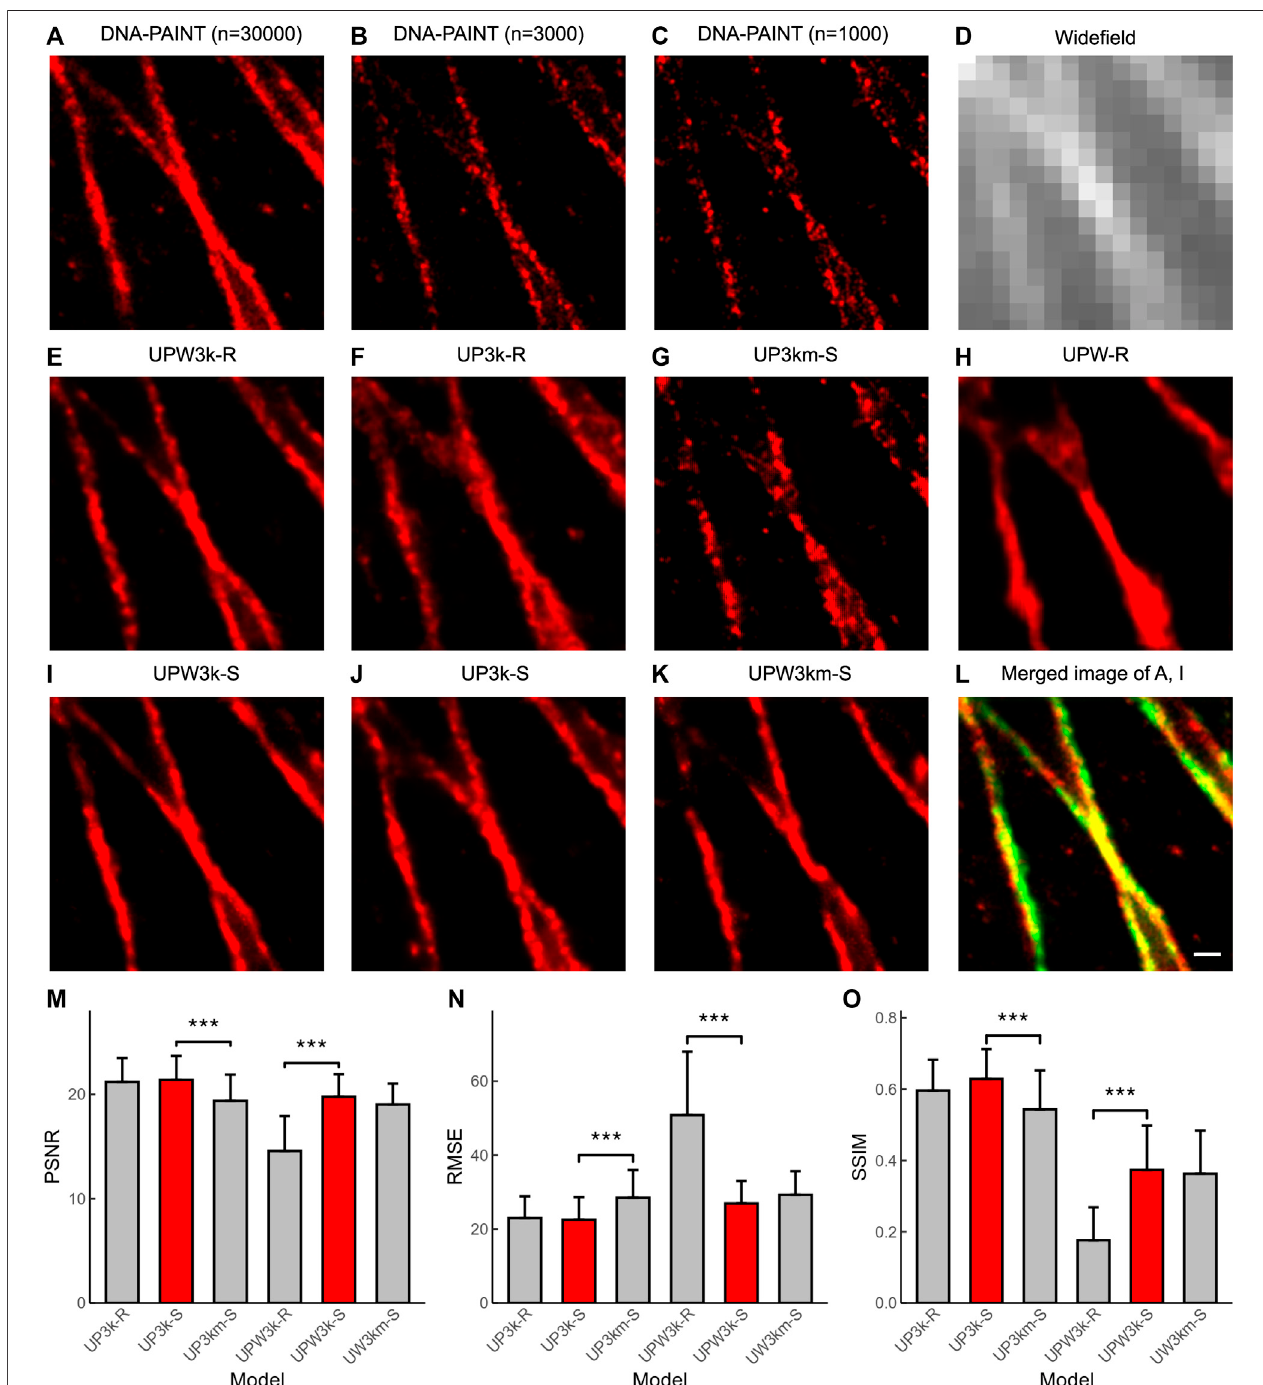
FIGURE 4 | U-PAINT reconstruction of microtubules. (A) DNA-PAINT reconstruction images with n = 30,000 raw data. (B) DNA-PAINT reconstruction image with n = 3,000 raw data. (C) DNA-PAINT reconstruction image with n = 1,000 raw data. (D) Wide fi eld image. (E) Real data-based U-PAINT (WF+3,000) reconstruction image with B and D as inputs. (F) Real data-based U-PAINT (3,000) reconstruction image with B as input. (G) Real data-based U-PAINT (1,000) reconstruction image with C as input. (H) Real data-based U-PAINT reconstruction image with (D) (I) Simulated and real data-based U-PAINT (WF+3,000) reconstruction image with B and D as inputs. (J) Simulated and real data-based U-PAINT (3,000) reconstruction image with B as input. (K) Simulated and real data-based U-PAINT (WF+3,000) reconstruction image with C and D as inputs. (L) Merged image of A (red) and I (green). (M) PSNR of U-PAINT models. (N) RMSE of U-PAINT models. (O) SSIM of U-PAINT models. Red bars refer to better U-PAINT models; bars are average values from testing dataset; error bars show s.d.; UP3k-R: U-PAINT (3,000) model trained with only real data; UP3k-S: U-PAINT (3,000) model trained with real and simulated data; UP3km-S: U-PAINT (3,000) model trained with real and simulated data, and the input was a sparse DNA-PAINT image localized from 1,000 frames of raw data; UPW3k-R: